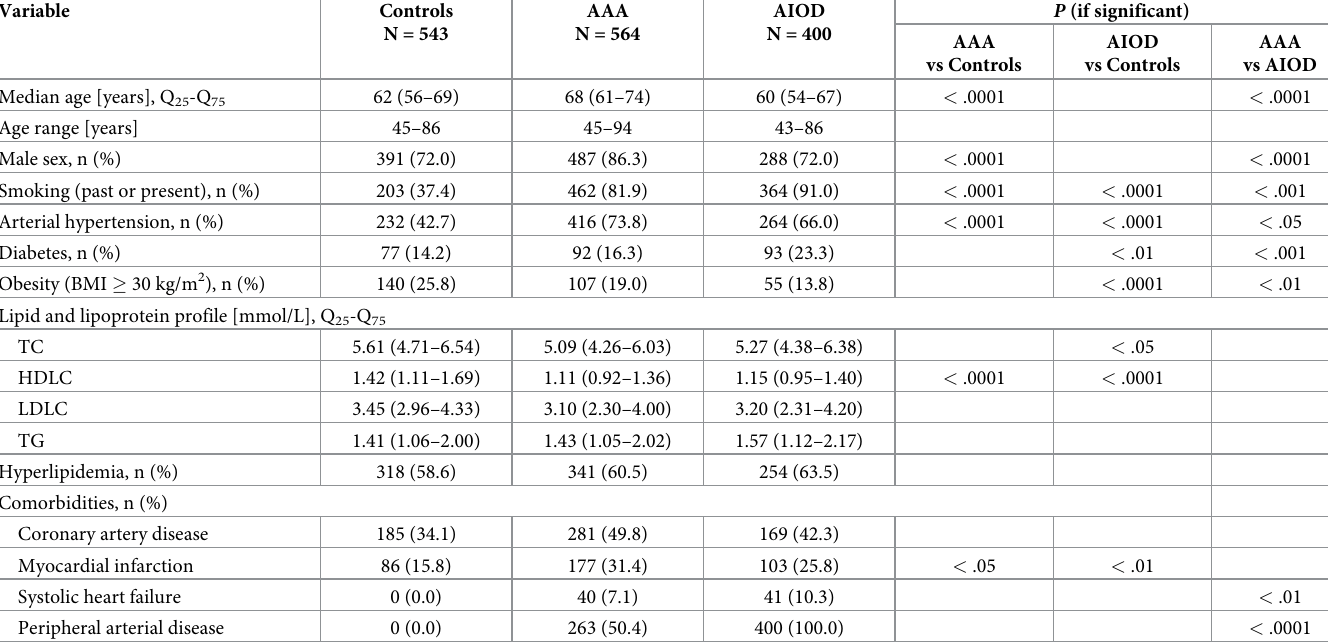
Table 1. Demographic and clinical characteristics of patients with abdominal aortic aneurysm (AAA), patients with aortoiliac occlusive disease (AIOD), and con- trol